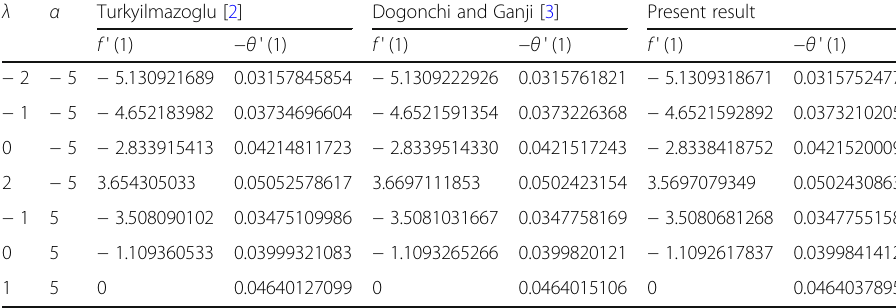
Table 2 Comparison of numerical value of f ' (1), for various values of stretching/shrinnking parameter λ and divergent/convergent parameter α , when Re = 50 and φ = 0